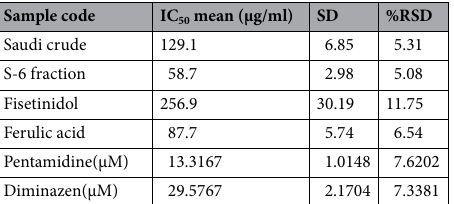
Table 3. Cytotoxicity assay of Saudi propolis sample and its fractions on U937